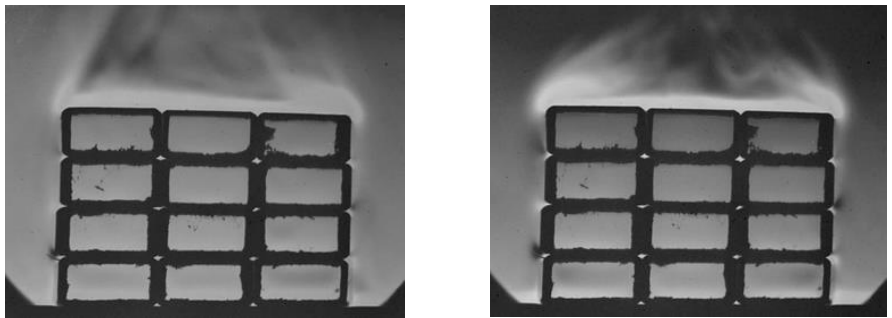
Figure 12. Schlieren images recorded during heating of the 20 × 40 mm sections.